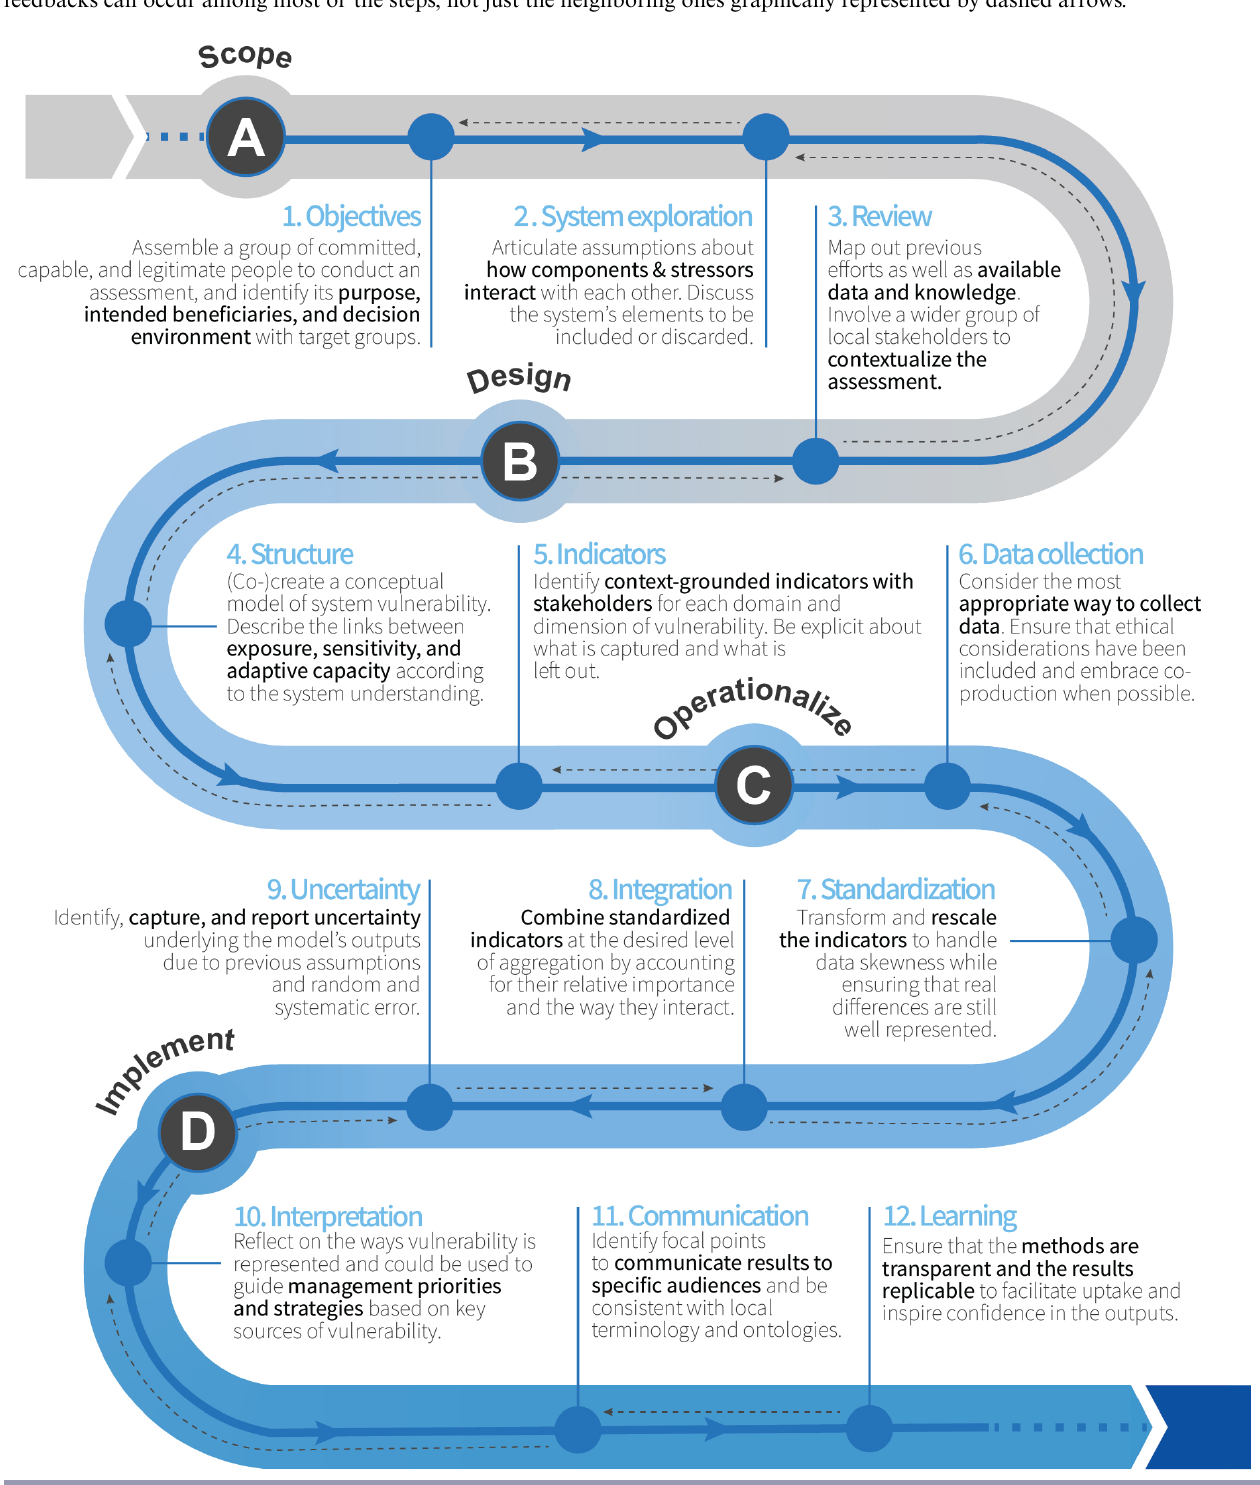
Fig. 1 . Flowchart of the four phases (A–D) and 12 steps (1–12) for conducting robust, context-specific, and policy relevant vulnerability assessments of social-ecological systems. The 12 steps are interlinked and allow for iterative learning opportunities; feedbacks can occur among most of the steps, not just the neighboring ones graphically represented by dashed